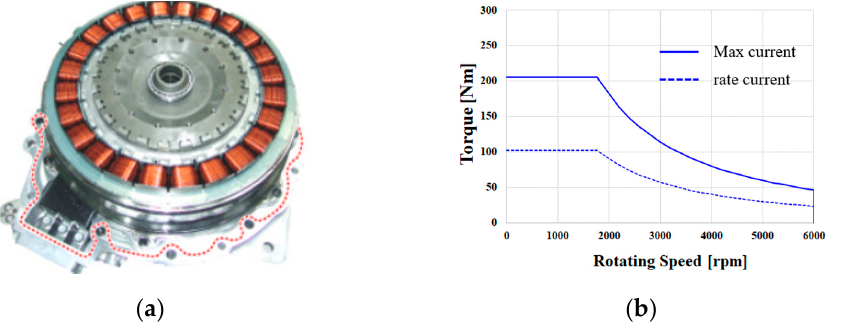
Figure 2. Picture and T–N curve of the 35 kW conventional hybrid traction model: ( a ) production model, ( b ) T–N curve of the conventional model. Table 1. 35 kW hybrid traction motor specifications.